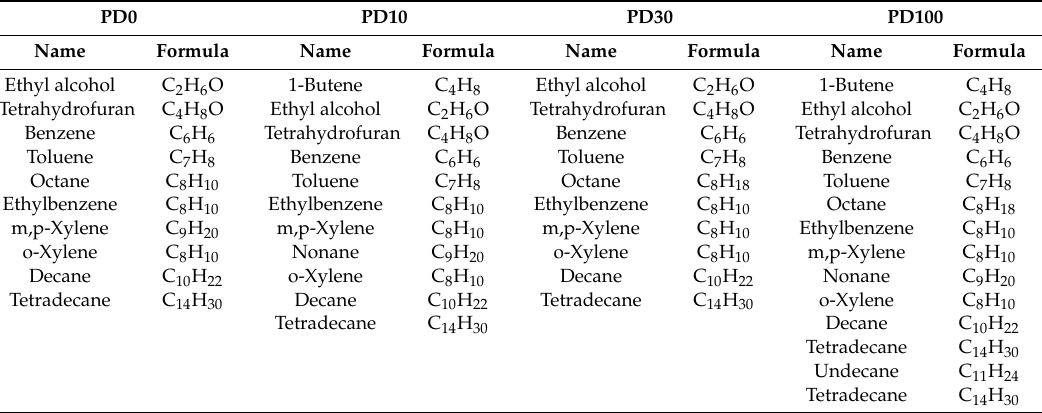
Table 8. List of VOCs observed under an engine load of 0